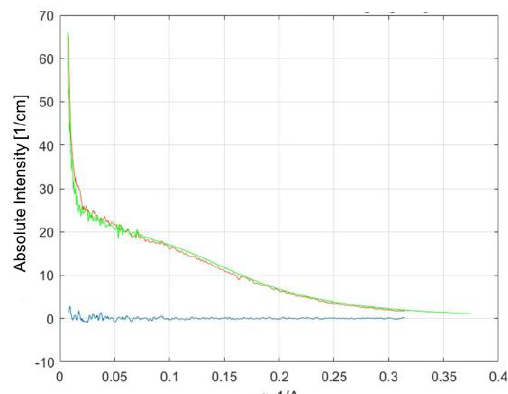
Figure 3. Lineouts showing absolute intensity vs. q measurements from glassy carbon sample from this SAXS experiment (red) and absolute intensity vs. q measurements from glassy carbon sample measured using USAXS; blue curve is air, shown for reference.